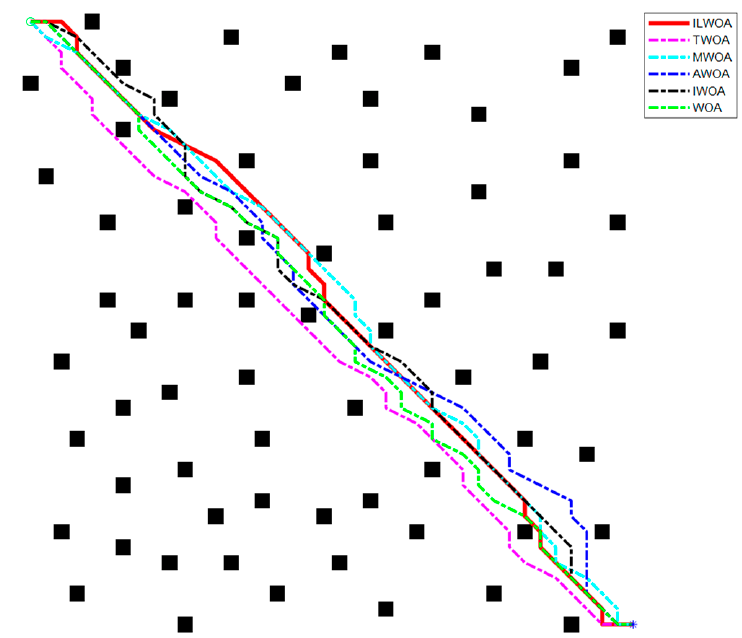
Figure 13. Robot path planning in Environment 2 scenario.